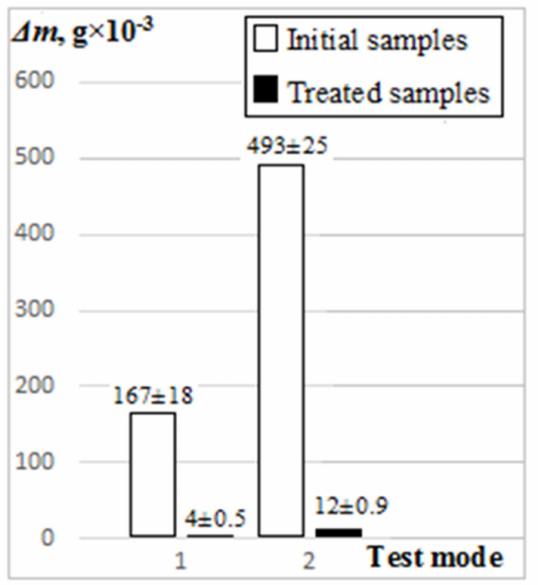
Figure 7. Samples wear in the tests: mode 1: τ = 600 s, P = 30 N; mode 2: τ = 1200 s, P = 50 N. During the samples tests on the tribological “ball-on-disk” tester after sliding distance of 100 m, the friction tracks formation on the titanium sample surface is observed. The process of friction is accompanied by a transfer of titanium on a harder steel counterbody (Figure 8a,b), which is typical for the process of titanium friction [8,9,14,16]. Similar tests on the treated samples show that the friction track on the surface is scarcely visible, but counterbody wear is observed (Figure 8c,d).